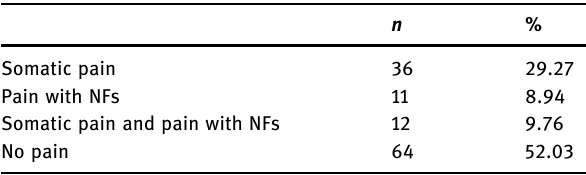
Table 2: Patient ’ s classi fi cation by